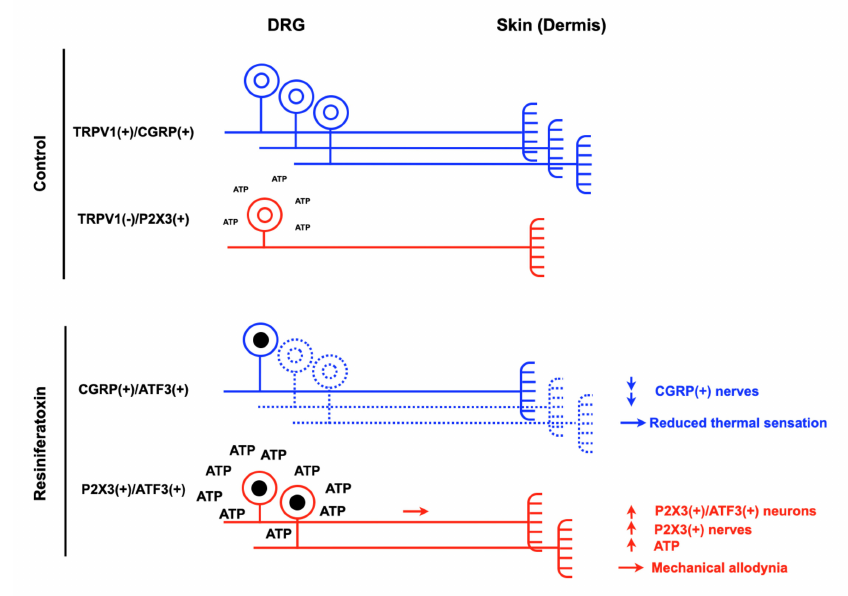
Figure 1. Schematic diagram illustrating the peripheral sensitization in resiniferatoxin (RTX)-induced neuropathic pain model. Thermal hypoalgesia and mechanical allodynia were observed after 1 week of RTX treatment. After RTX exposure, several dorsal root ganglia (DRG) profiles were changed including the increase of purinergic receptor P2X3 (P2X3)( + ) / activating transcription factor 3 (ATF3)( + ) neurons and the decrease of transient receptor potential vanilloid subtype 1 (TRPV1)( + ) / calcitonin gene-related peptide (CGRP)( + ) neurons. At the terminal ending of nerve, the phenotype of dermal nerve also had similar changes as the DRG. The number of CGRP( + ) and P2X3( + ) nerve were decreased and increased